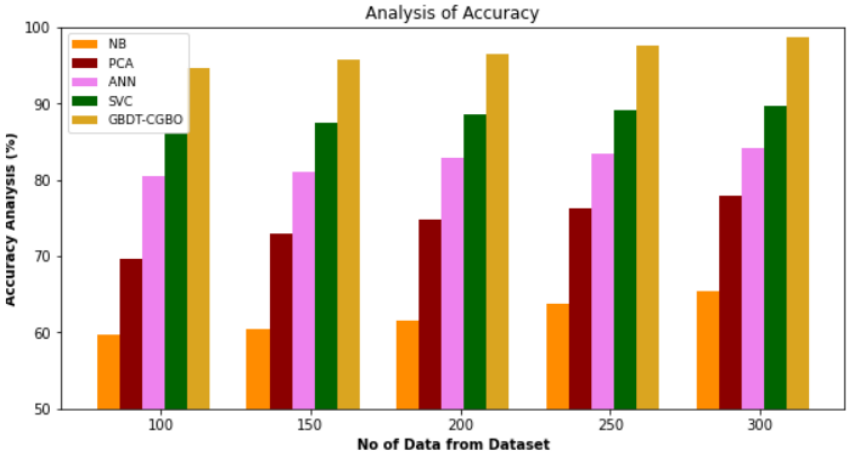
Figure 7. Accuracy Analysis of GBDT-CGBO method with existing system. Table 6. Accuracy Analysis of GBDT-CGBO method with existing system in percentage. No of Data from Dataset Naïve Bayes